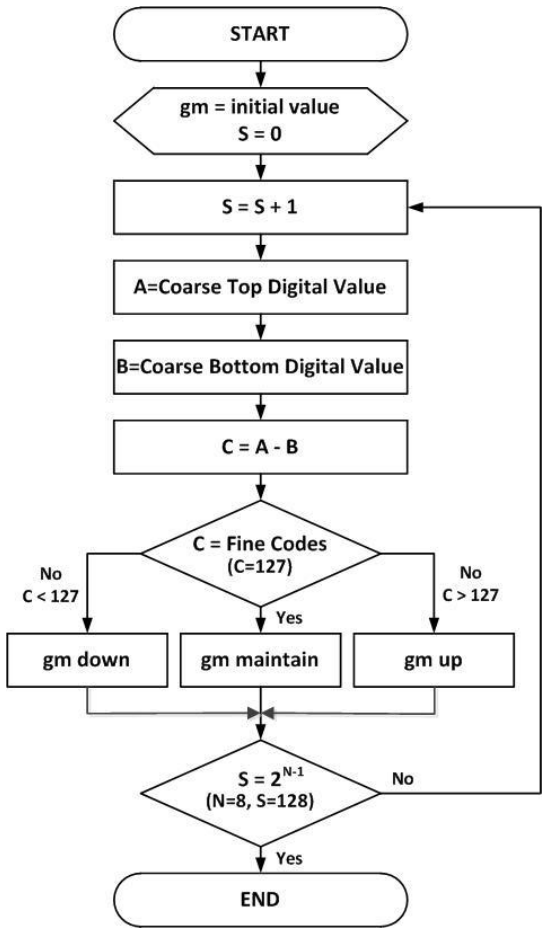
Figure 10. Flow chart of proposed self-calibration